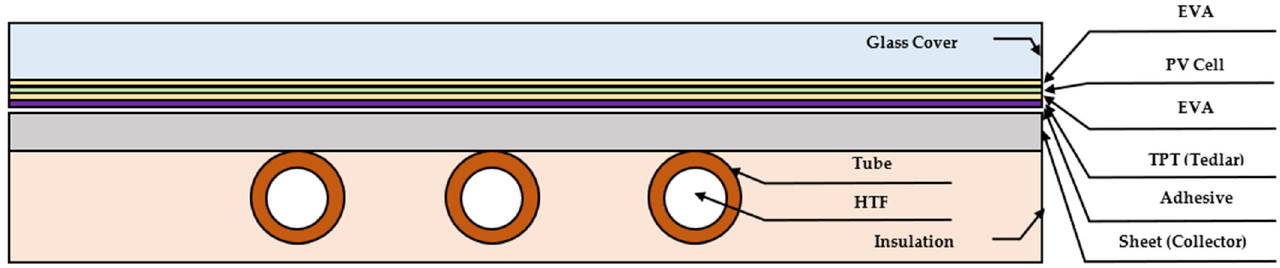
Figure 2. A typical arrangement of the ST-PVT